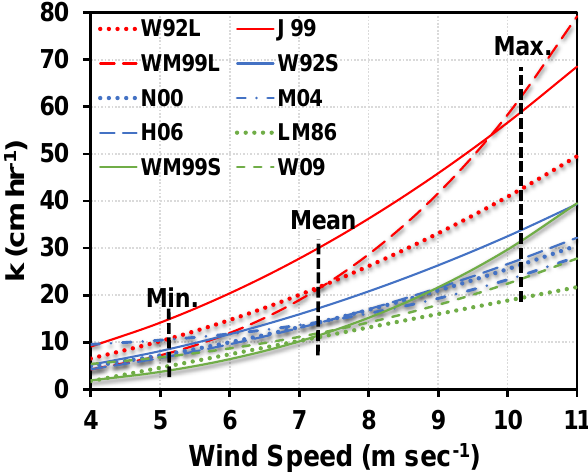
Figure 10. Comparison among different algorithms for flux calcu- lation against wind speed (LM86 corresponds to Liss and Merlivat (1986); other labels see in Table 4). Black dashed lines in min, mean and max denote the minimum, average and maximum monthly aver- age wind speeds obtained from PenGaYi station in the ECS during the study period.